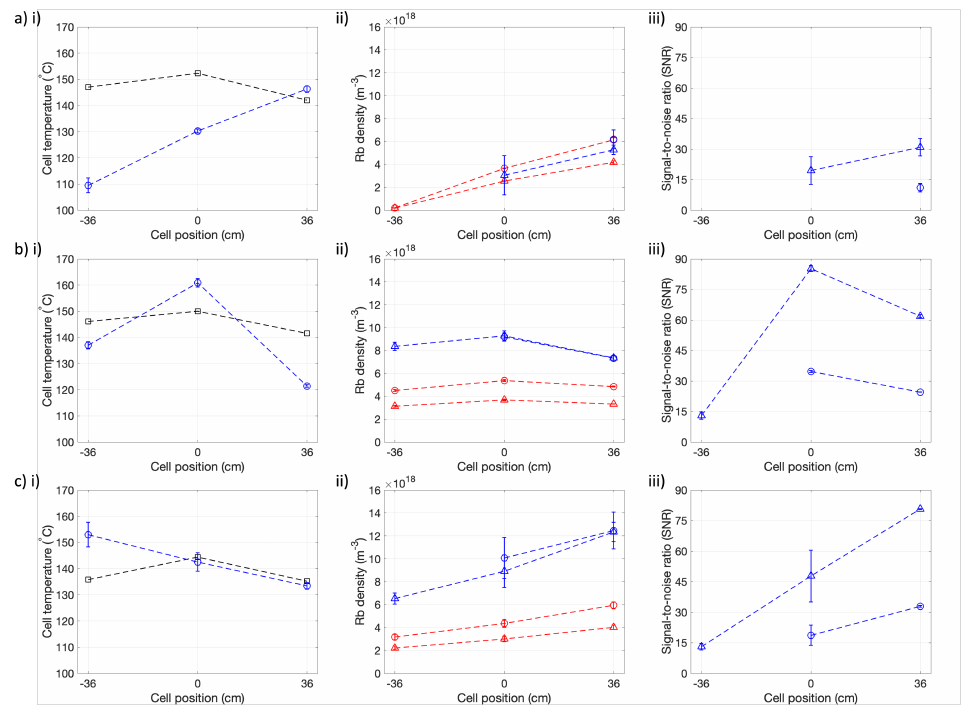
Figure 5. ( i ) Cell temperature, T cell , ( ii ) Rb density, [ Rb ] ( iii ) signal-to-noise ratio (SNR) in violet absorbance spectra at different cell positions for ( a ) 1 g Rb main body cell, ( b ) 5 g Rb main body cell and ( c ) 2 g Rb presaturator cell (see Figure 1). T cell was measured during continuous flow SEOP (blue circles) and with the cell closed without the pumping laser present (black squares). [ Rb ] measured from the 5 S 1/2 → 6 P 1/2 (blue circles), 6 P 3/2 (blue triangles), 5 P 1/2 (D 1 ) (red circles), 5 P 3/2 (D 2 ) (red triangles) transitions. Dashed lines are to guide the eye only. The presaturator temperature was measured to be 164.0 ± 0.8 ◦ C. SNR in D 1 and D 2 absorbance spectra was high (>100) and so was not included in ( iii ) plots. N.B.: in ( ai ), ( bi ) and ( ci ) T cell measured without the pumping laser present do not have an error bars due to only one measurement